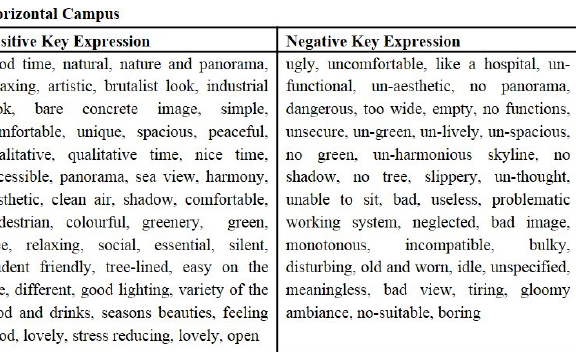
Table 7. Evaluative categories and key expressions from scene descriptions of horizontal campus